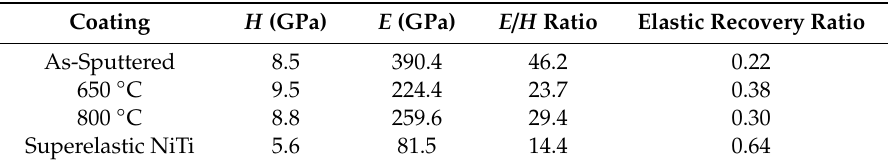
Table 1. Nanoindentation